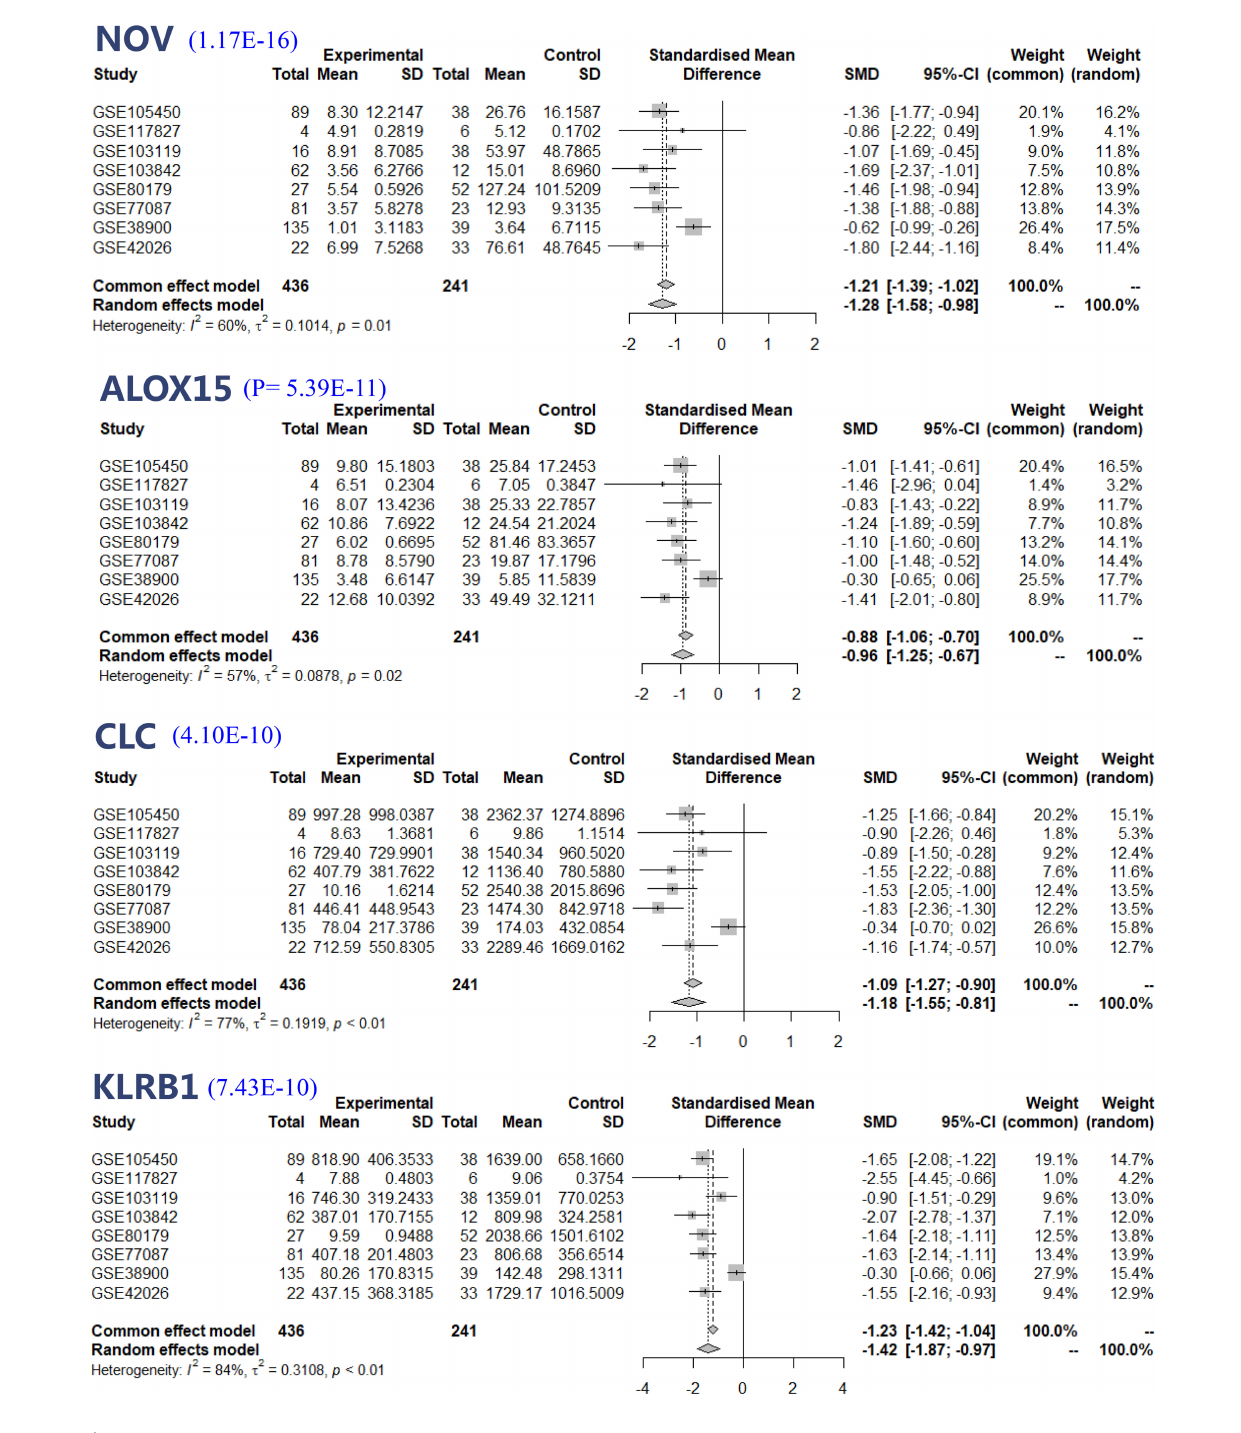
FIGURE 4 | Forest plot based on random effect models of continuous variable